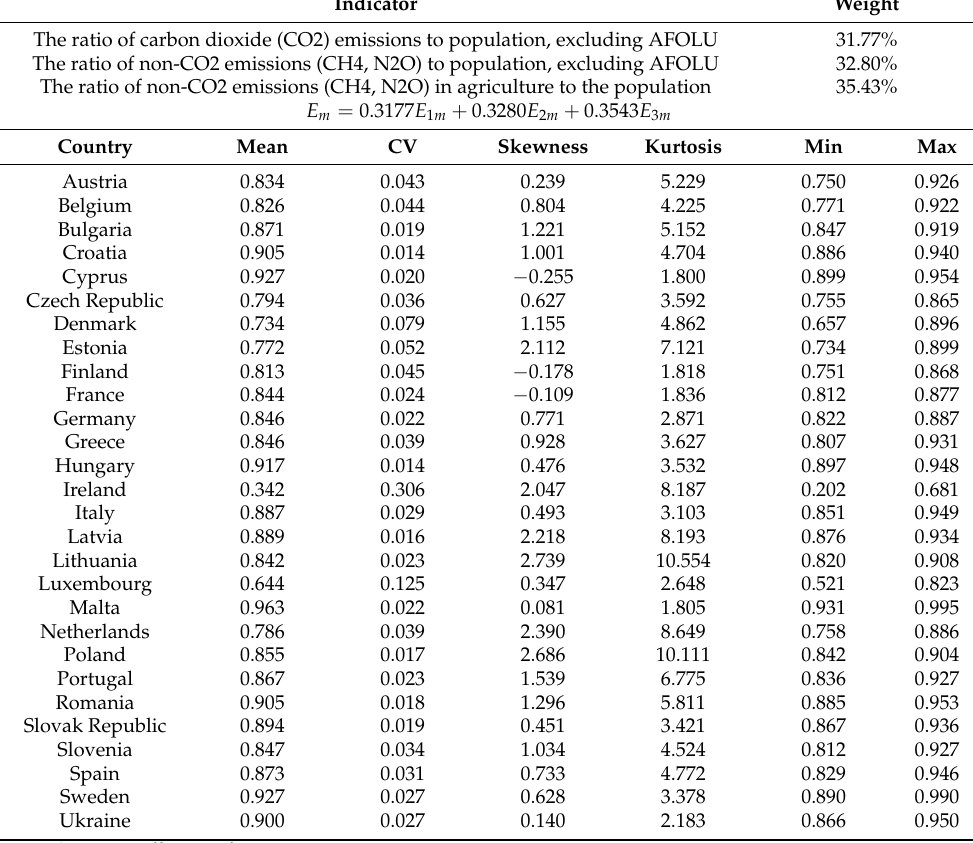
Table 3. An integrated index of natural capital pollution and weight of the relevant indicators. Indicator Weight 31.77% The ratio of non-CO2 emissions (CH4, N2O) to population, excluding